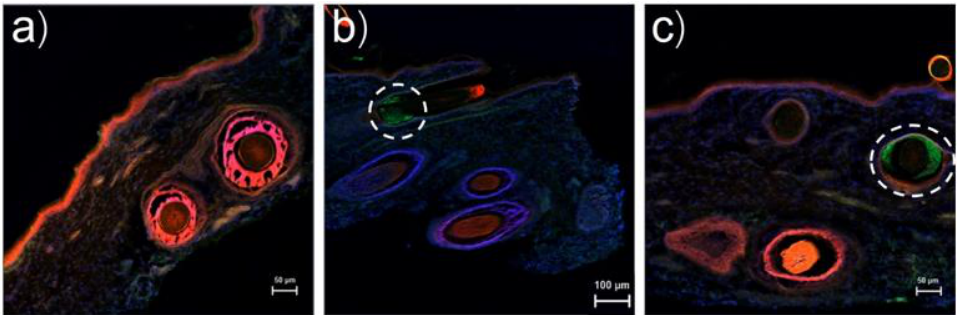
Figure 6. ( a ), ( b ), and ( c ) Cross-sectional images of skin treated with rhodamine B base-loaded NBD-PE-labeled UL and stained with DAPI in different regions. The white circles indicate the presence of UL vesicles inside hair follicles in which the entrapped drugs were released.